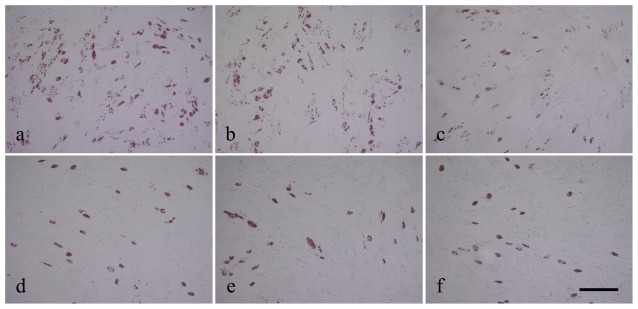
The effect of leptin on adipogenesis of MSCs from a normal control (18y, male) and an AIS patient (15y, male, Cobb angle = 54°).Cells from the normal control were induced along the adipogenic differentiation with human recombined leptin protein at concentration of 0 µg/mL (a), 0.015 µg/mL (b) and 0.6 µg/mL (c). MSCs from the AIS patient were also treated under the same condition that containing leptin of 0 µg/mL (d), 0.015 µg/mL (e) and 0.6 µg/mL (f). At day 12, the cells were subjected to Oil Red O staining. Scale bar = 500 µm.